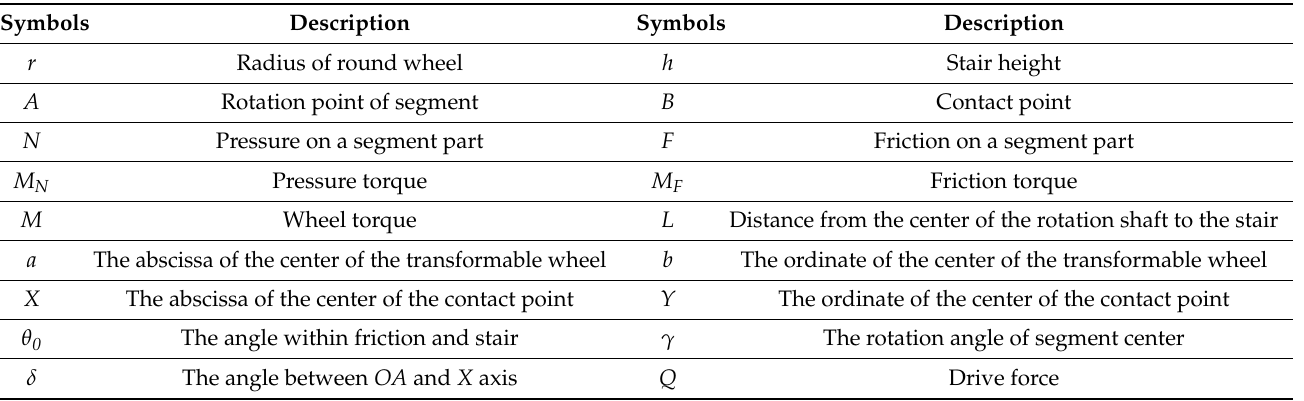
Table 1. The parameter symbols used in this manuscript. Symbols Description Symbols Description Radius of round wheel h Stair height Rotation point of segment B Contact point Pressure on a segment part F Friction on a segment part Pressure torque M F Friction torque Wheel torque L Distance from the center of the rotation shaft to the stair b The ordinate of the center of the transformable wheel Y The ordinate of the center of the contact point γ The rotation angle of segment center